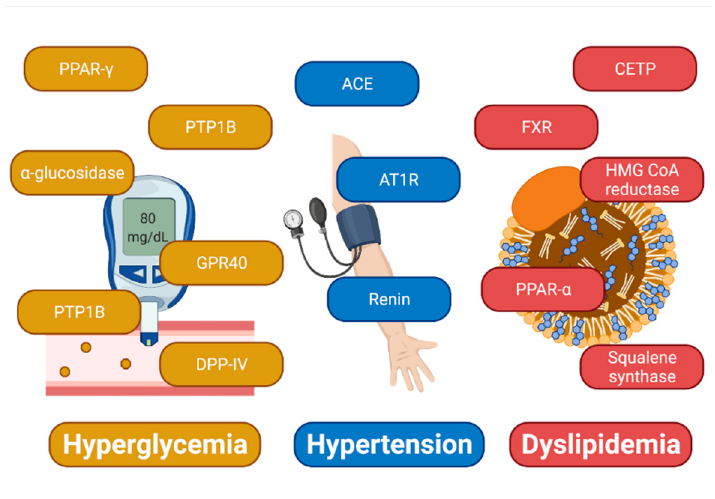
Figure 1. Examples of drug targets proposed for the treatment of components of